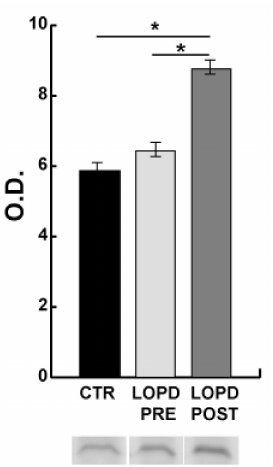
Figure 6. Endoplasmic reticulum (ER) stress. Representative immunoblot images and histograms (mean ± SD) showing protein abundance of C/EBP-homologous protein (CHOP/DDIT3). The data were normalized against the total amount of loaded proteins stained with Sypro Ruby. Statistical analysis was performed by ANOVA and Tukey’s test (* p < 0.05). To improve visualization blot images have been cropped, full-length images are available in Supplementary material (Figure